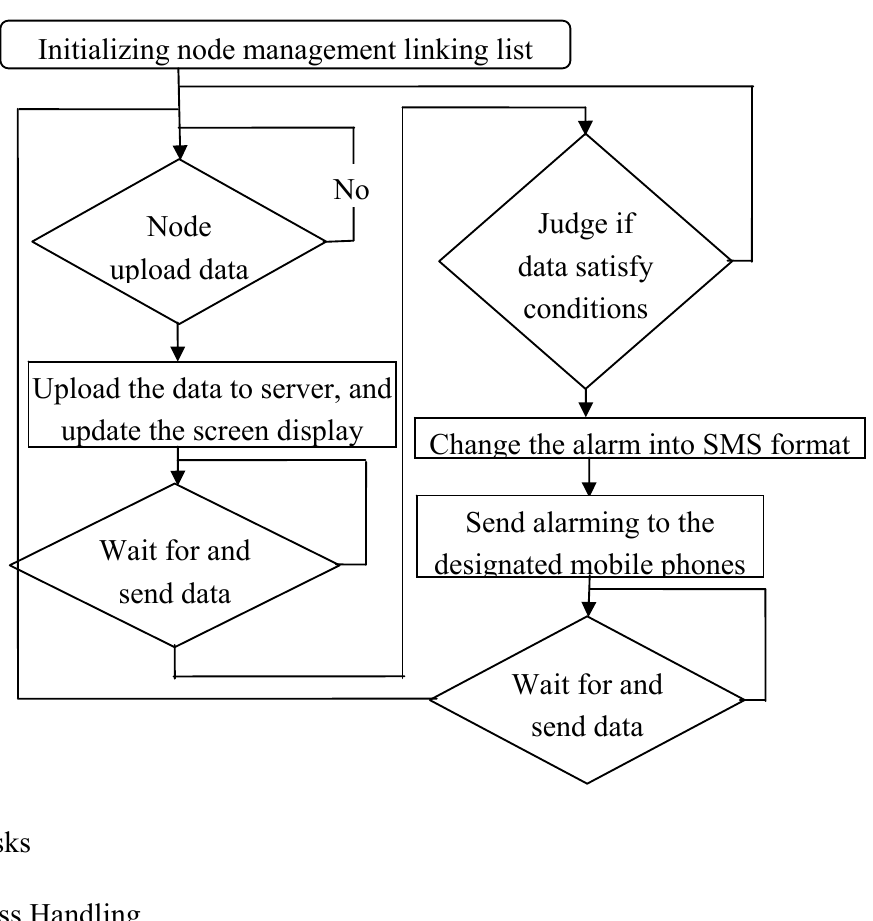
Figure 13. Implementation of data processing tasks